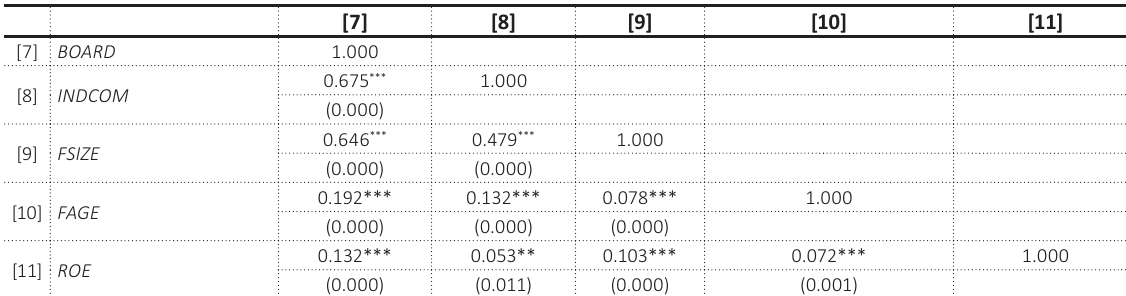
Table 3 (cont.). Pearson